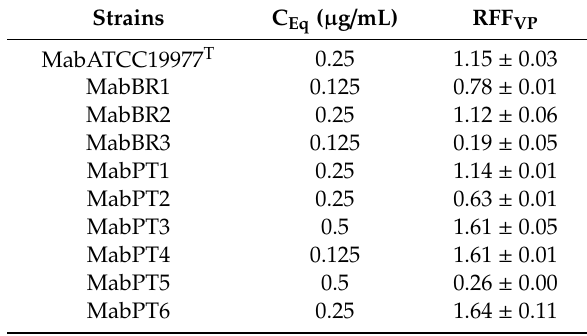
Table 4. Characterization of the M. abscessus strains according to their e ffl ux